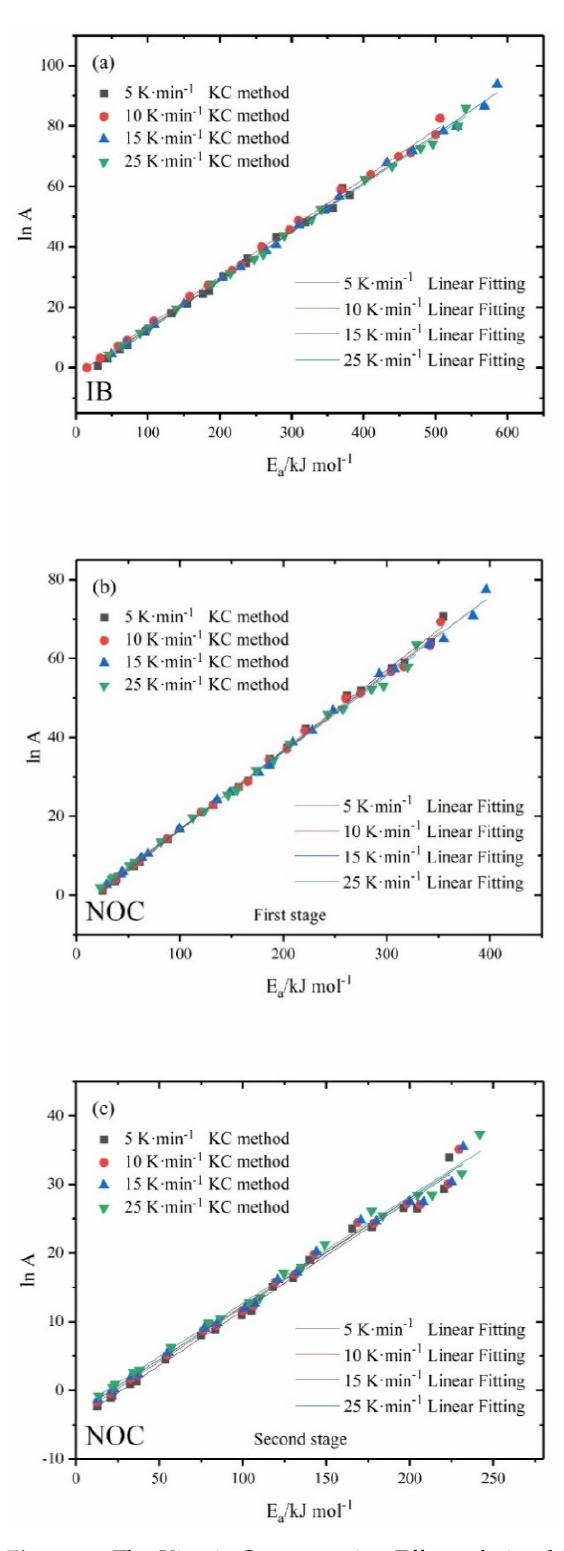
Figure 5. The Kinetic Compensation Effect relationship by Kennedy-Clark method at different heating rates: ( a ) IB, ( b ) the first pyrolysis stage of NOC, ( c ) the second pyrolysis stage of NOC.